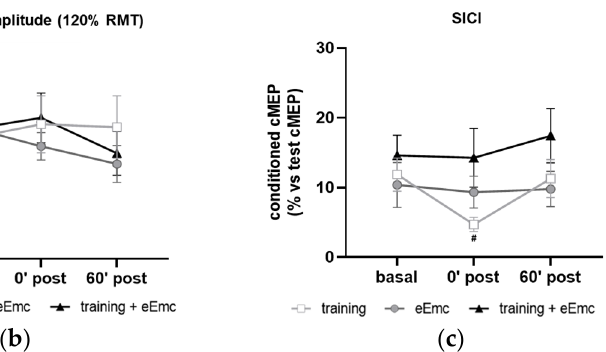
Figure 5. Effect of hand training, eEmc and eEmc + training on the corticospinal excitability and SICI. ( a ) Percentage of resting motor threshold (RMT) vs. baseline levels in APB at 0 min (0′ post) and 60′ min (60′ post) after intervention. Signif- icant differences between interventions: p < 0.05, (training vs. eEmc + training), and in comparison to baseline: # p < 0.05 (for training). ( b ) Effect of training, eEmc and eEmc + training on the supramaximal cMEP amplitude (120% transcranial magnetic stimulation (TMS)) according to RMT. ( c ) SICI: (average of conditioned cMEP) × 100/ (average of test cMEP) recorded at APB muscle and obtained at 0′ and 60′ after each intervention. # p < 0.05 for training at 0′ post in comparison to baseline. APB, abductor pollicis brevis; RMT, resting motor threshold; cMEP, cortically-induced motor evoked poten- tial; SICI, short-interval intracortical inhibition.